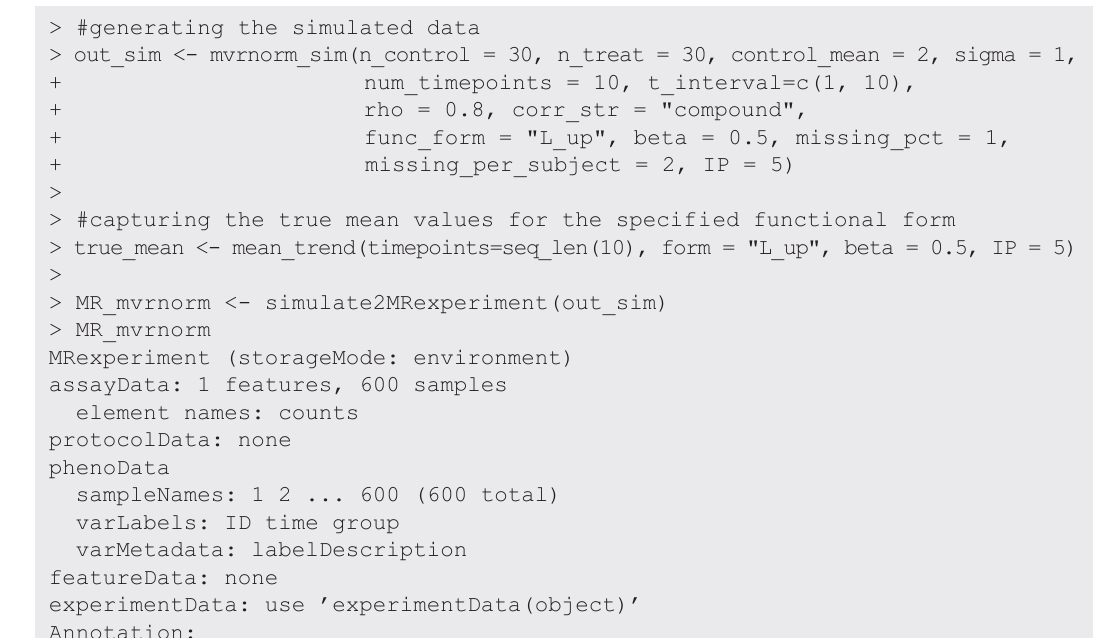
= n = 30 individuals per arm. 0 1